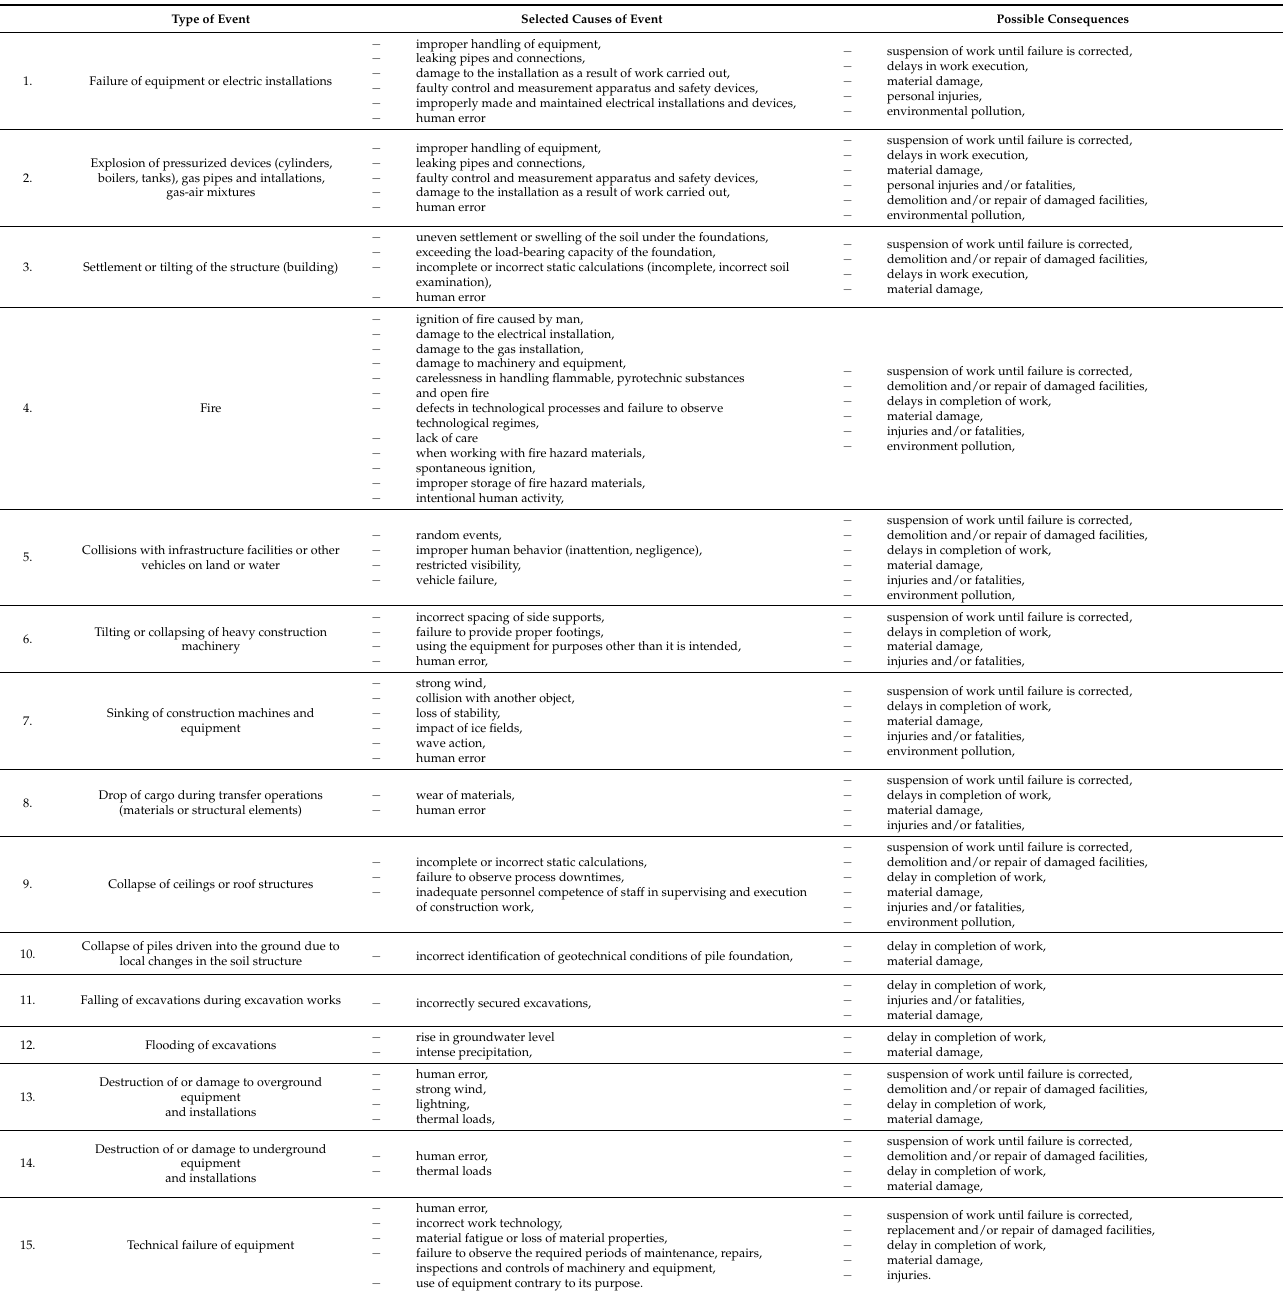
Table 3. Identification of selected events occurring during seaport